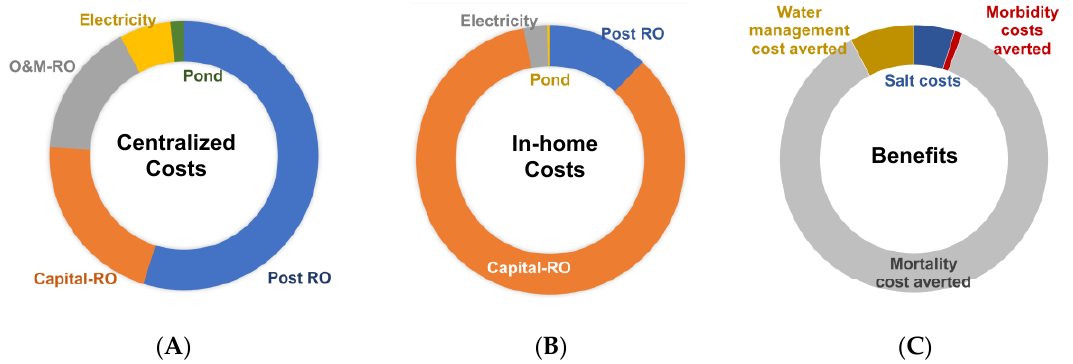
Figure 3. Components of the costs in the ( A ) centralized and ( B ) decentralized (in-home) configurations, along with the ( C ) benefits which are very similar in both configurations.